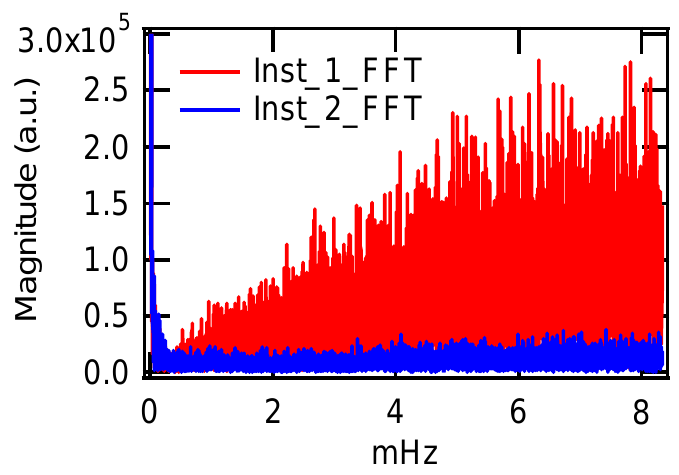
Figure 7. Spectrum of Fast Fourier Transform (FFT) for the black carbon (BC) concentration collected by Inst_1 and Inst_2 every minute.